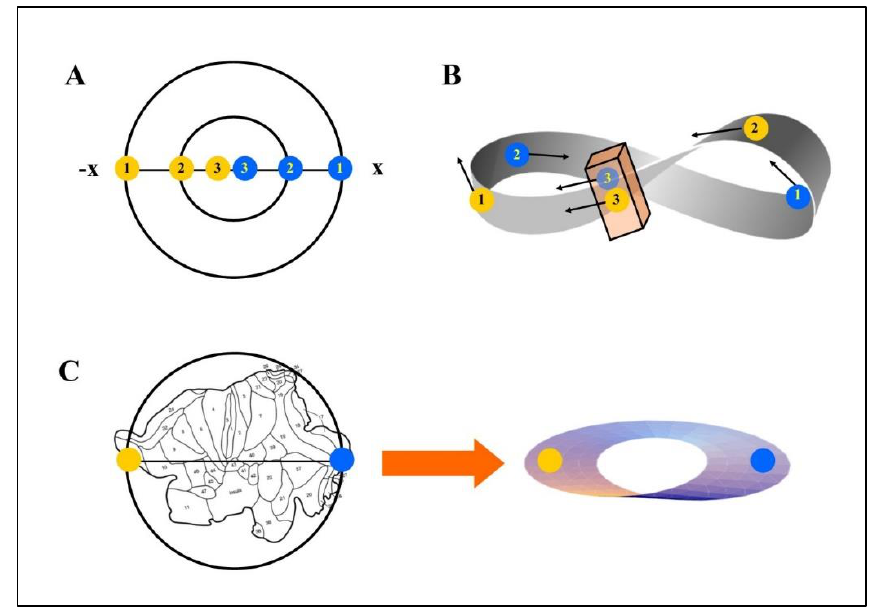
Figure 2 . Transport of the BUT theorem on a Möbius strip. Figure 2A. Changing the radius of the hypersphere makes the antipodal points more or less close. Close to the center, the two points (marked with the number 3) are almost superimposed. Figure 2B. The movements of the antipodal points can be described in terms of trajectories on a Möbius strip. The parallelepiped stands for a slice of time, where both the antipodal features occur simultaneously. Figure 2C. A theoretical example from neuroscience is provided. A cerebral hemisphere is unfolded and flattened into a two-dimensional reconstruction [26] that can be embedded into a circular manifold. When two antipodal areas display simultaneously a feature in common, e.g., the same value of pairwise entropy [27], we achieve a topological description assessable in terms of BUT (left side). Such two areas and their subsequent dynamics can be easily visualized and assessed in terms of trajectories taking place on an abstract twisted cylinder (right